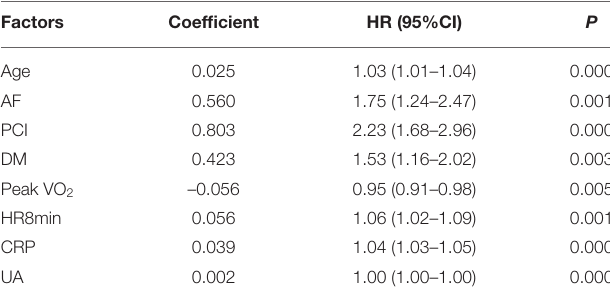
TABLE 3 | The selected variables for model construction.